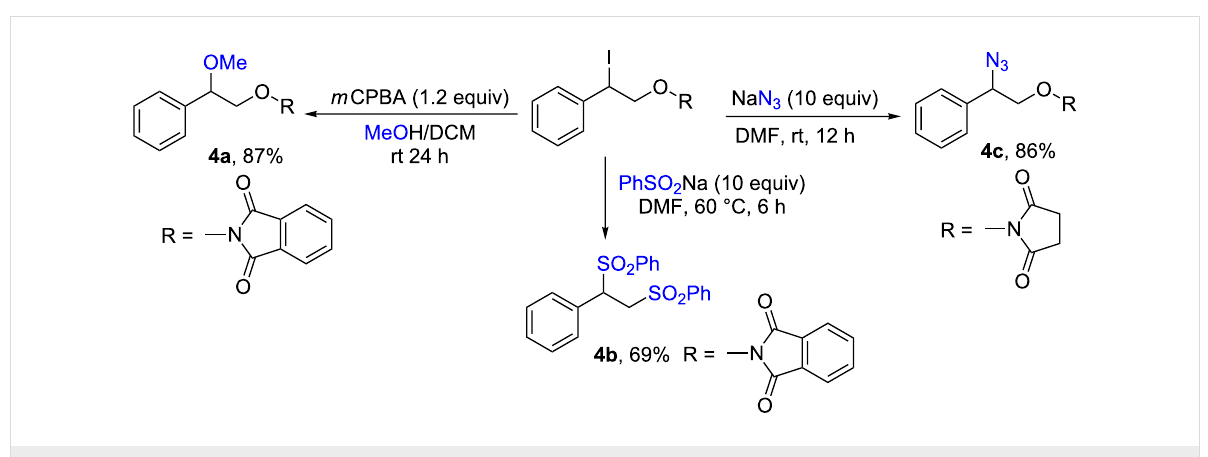
Scheme 5: Synthetic utility of the iodo-oxyimides 3aa and 3ab